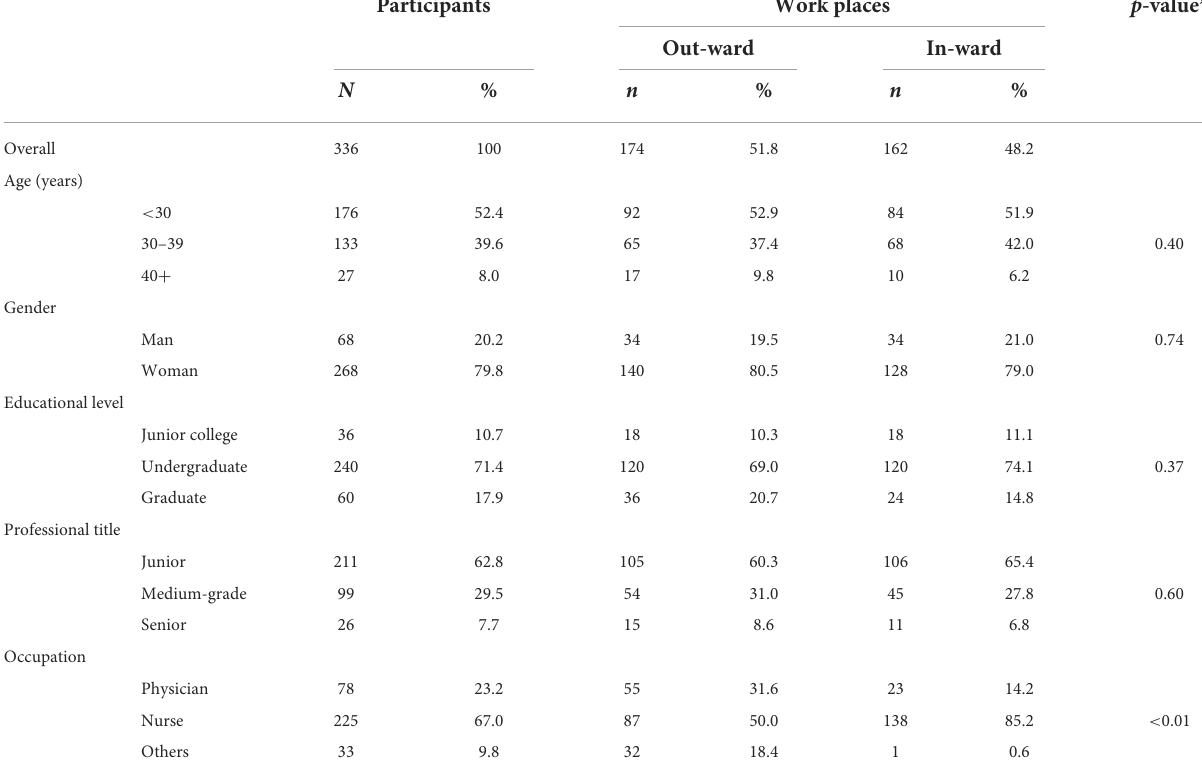
TABLE 1 Selected characteristics of participants in the study. Participants Work places